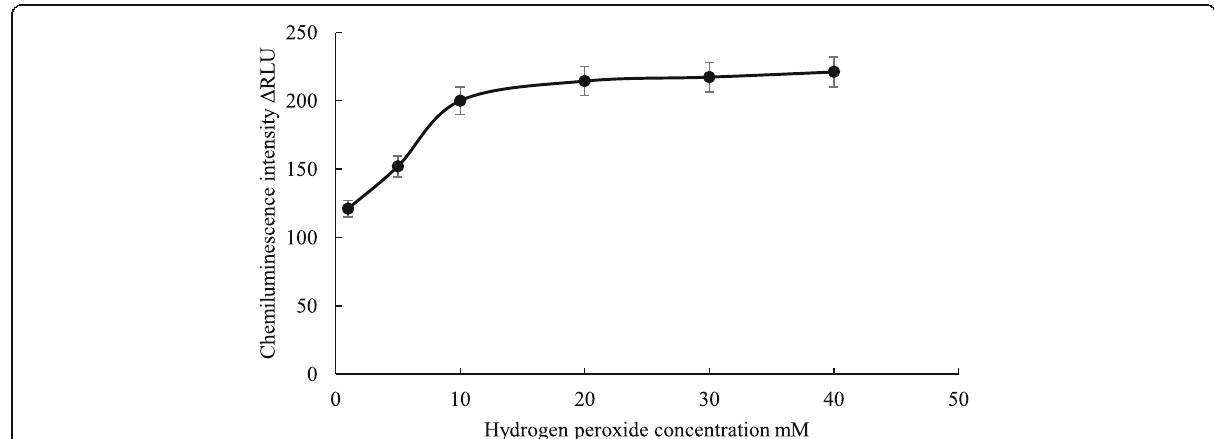
Fig. 6 Graph showing the influence of hydrogen peroxide concentration while keeping the concentration of luminol constant (20 mM) on the CL emission signal